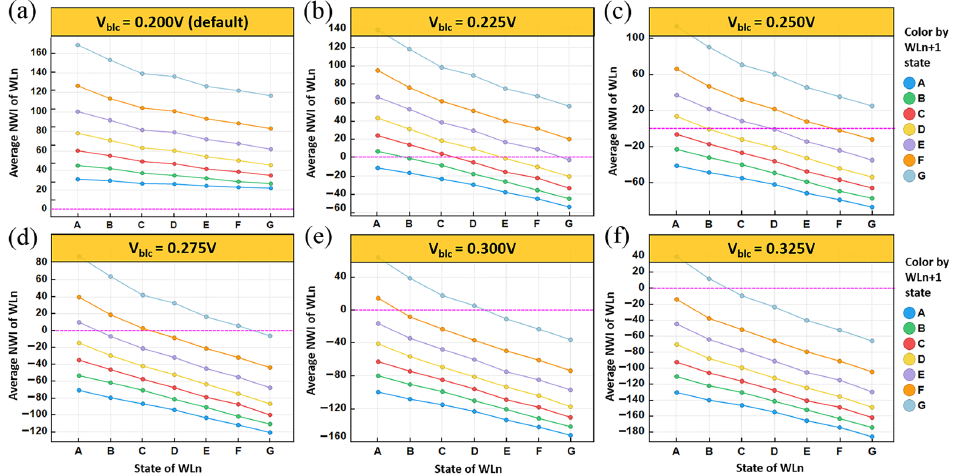
Figure 9. All-state NWI curves drawn from chip test with different V blc are shown in ( a – f ). NWI has a dependency on the V blc during reading. A higher V blc applied during reading makes less NWI than the default.